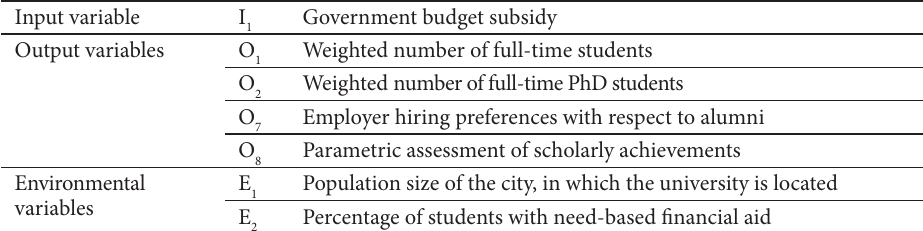
Table 6. Variables selected for DEA